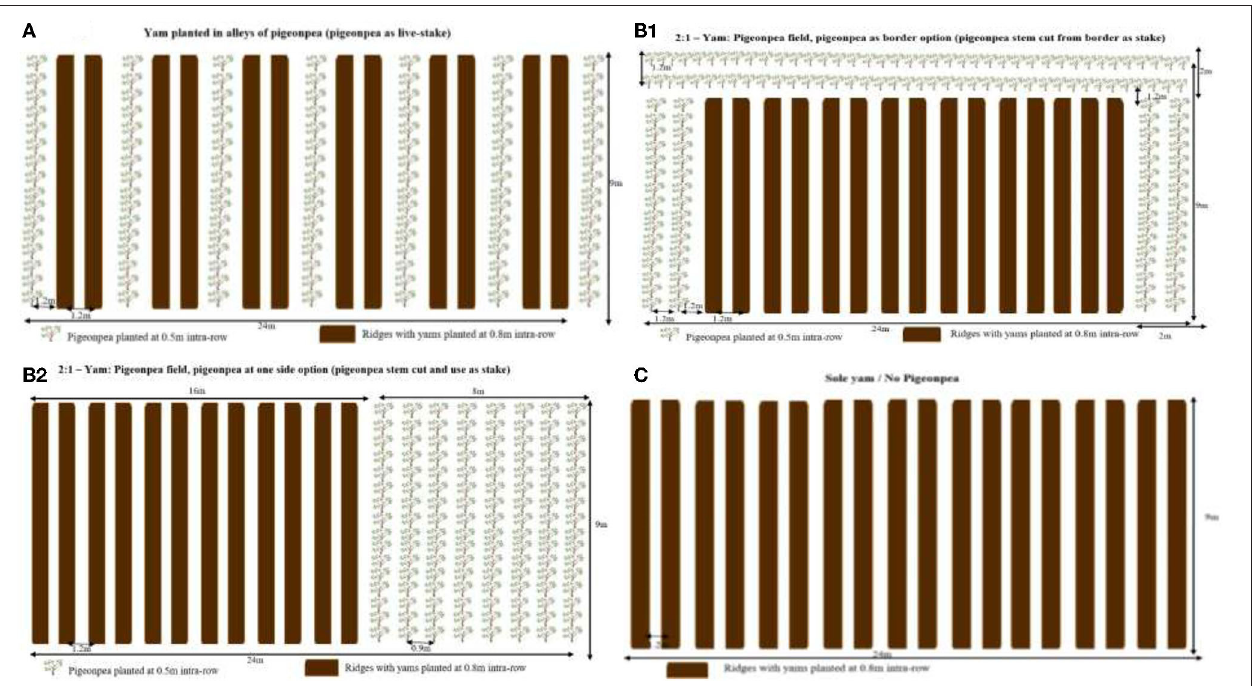
FIGURE 5 | A pictorial illustration of the pigeonpea–yam cropping system options compared with sole yam. (A) Yam planted in alleys of pigeonpea with pigeonpea as live-stake; (B1) 2:1—yam: pigeonpea with pigeonpea as border option, pigeonpea stems cut from the border as stake; (B2) 2:1—yam: pigeonpea with pigeonpea at one side option, pigeonpea stem cut and used as stake; (C) Sole yam, bamboo stakes purchased and sent to the field for staking ( Source: Owusu Danquah, 2020).